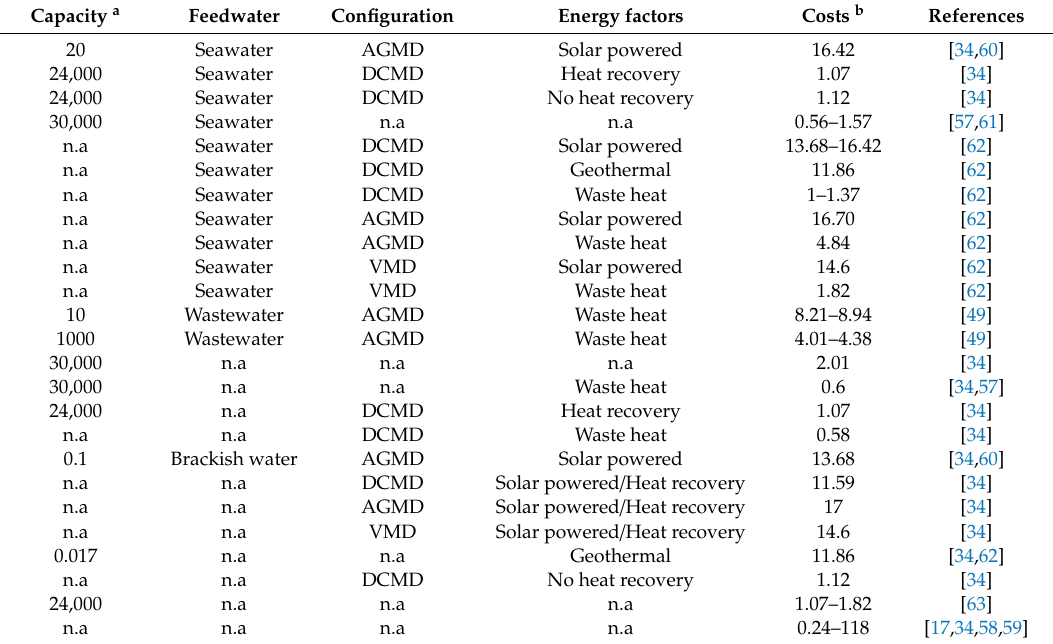
Table 1. Economic evaluation studies of membrane distillation (MD) and water costs. As far as possible, factors such as feed capacity and characteristics (type of water, MD configuration, heat recovery mechanisms and energy source) have been